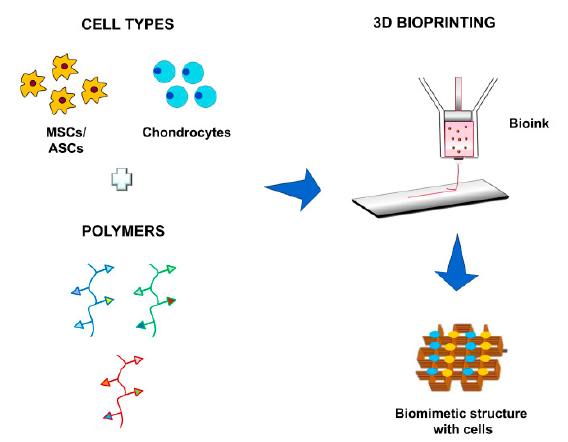
Figure 4. Schematic representation of the bioprinting process. Cells and polymeric scaffolds are mixed together (bioink) and dispensed on a substrate in a layer-by-layer approach, in order to build a living structure mimicking native tissue.